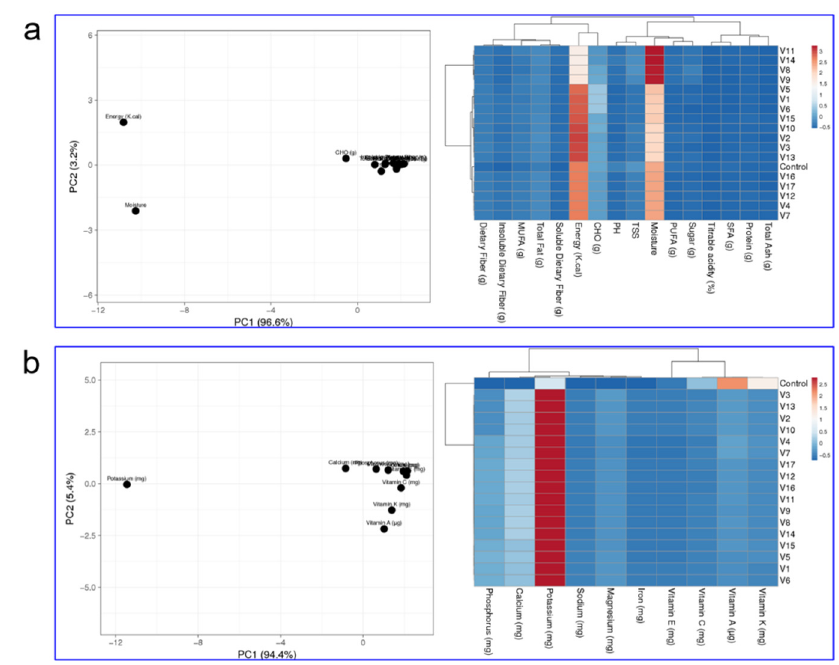
Figure 2. Principal component analysis and cluster-embedded heatmap of sensory characteristics, proximate composition ( a ), vitamin and mineral ( b ) composition of the formulated avocado juice with the aid of statistical